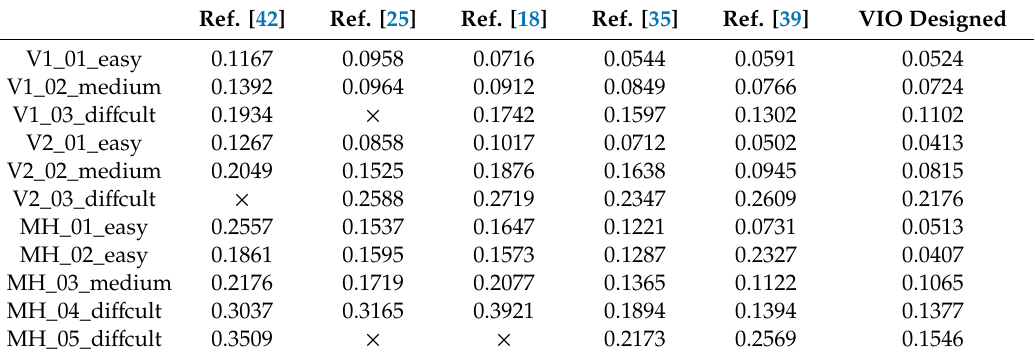
Table 3. The comparative absolute positioning errors in the European Robotics Challenge (EUROC)